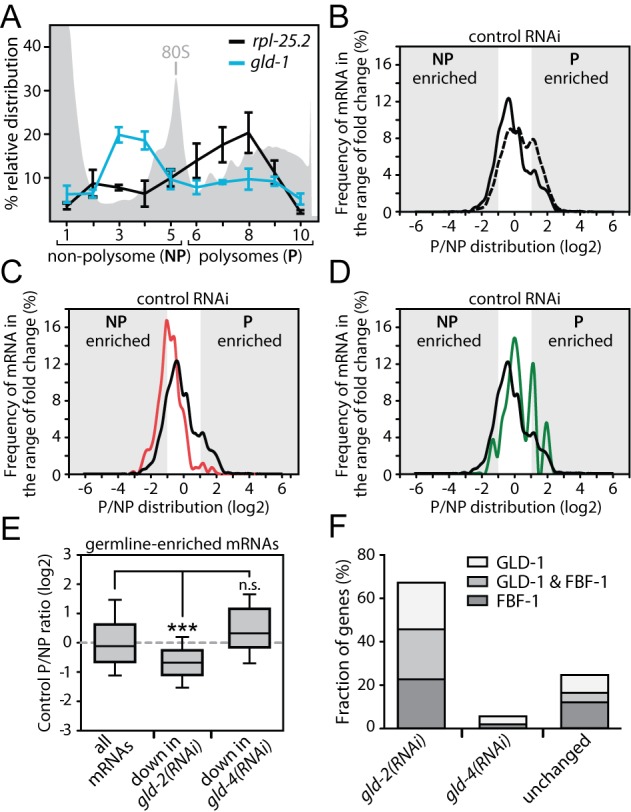
gld-2 promotes abundance of poorly translated germline mRNAs. (A) The relative gradient distribution of rpl-25.2 and gld-1 mRNA in animals treated with control RNAi is analyzed by RT-qPCR. Shown is the mean (±SEM) from 10 fractions in three independent experiments. (B–D) The gradient distribution of different groups of mRNAs was analyzed between polysome (P) and non-polysome (NP) fractions for control RNAi-treated animals. Shown are (B) all detected genes (dotted line–7649 mRNAs), (B, C and D) germline-enriched genes (solid black line–2243 mRNAs), (C) germline genes that are less abundant in gld-2(RNAi) (solid red line–444 mRNAs) and (D) germline genes that are less abundant in gld-4(RNAi) (solid green line–54 mRNAs). (E) P/NP distribution of the indicated groups of germline mRNAs. Significance was calculated with a Student's t-test: ***P < 0.001; n.s., not significant. (F) A large percentage of GLD-2-stabilized germline mRNAs are also GLD-1 and FBF-1 targets. The percent overlap between GLD-2-regulated mRNAs and putative GLD-1 and FBF-1 target mRNAs are given. mRNAs that are not decreased in gld-2(RNAi) are labeled as unchanged.